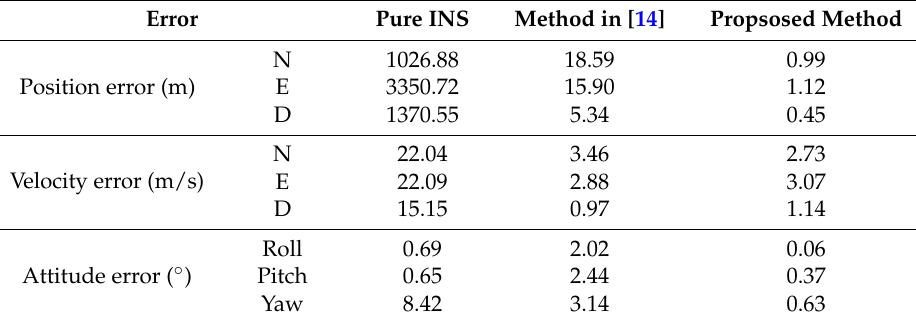
Table 3. RMS navigation parameter error of the simulation.